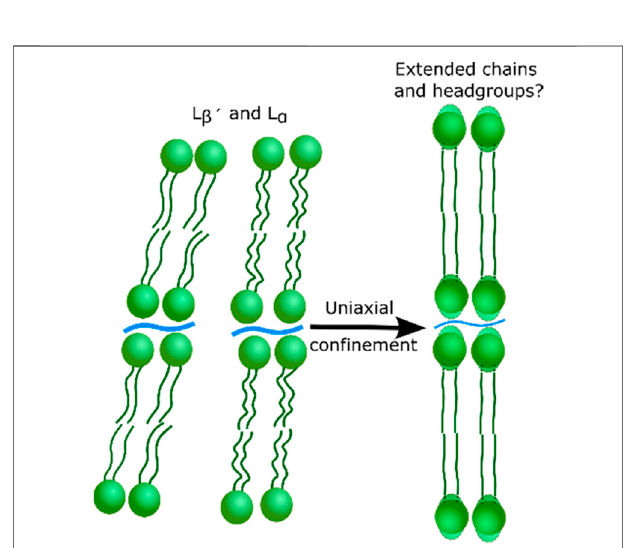
FIGURE 4 | Cartoon to illustrate the possible re-ordering of the lipid bilayers indicated by the con fi nement of lipid stacks.